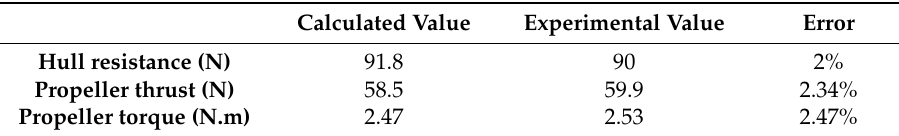
Table 3. KCS resistance calculation results with